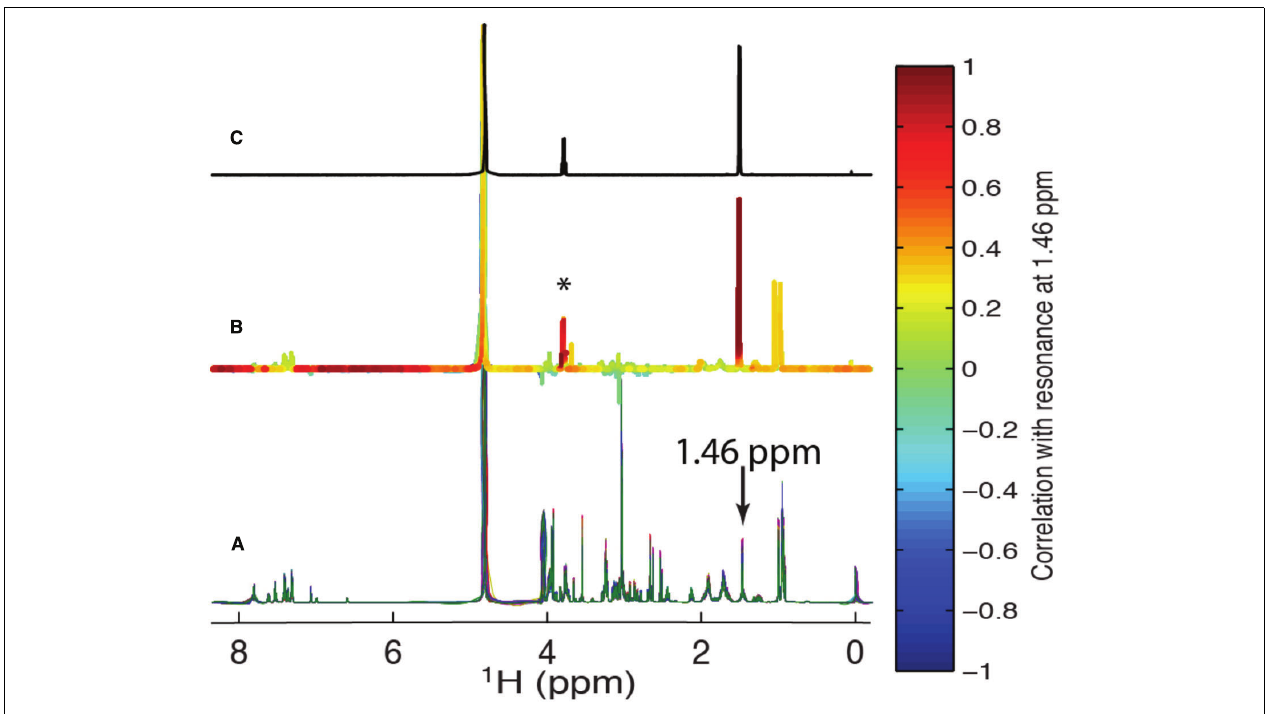
FIGURE 5 | Statistical total correlation spectroscopy (STOCSY; Cloarec et al., 2005). In (A) we simulated 100 different spectra from a mixture of 20 common metabolites obtained from the BMRB (Ulrich et al., 2008). The concentrations of the metabolites were randomly adjusted in each spectrum.